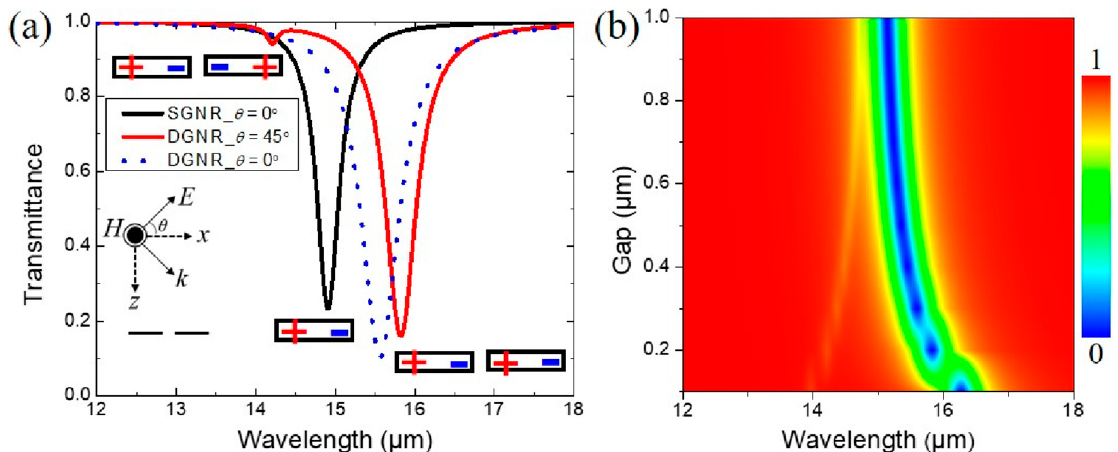
Figure 2. ( a ) Transmittance of the graphene nanoribbon dimer (GNRD) with d 1 = 0.2 μ m, with the inclined incidence angle ( θ ) being 0° and 45°, and the single GNR with θ being 0°. The insets of ( a ) show the corresponding plasmon mode for each spectral dip. ( b ) Transmittance of the GNRD under inclined incidence ( θ = 45°) of light with various d 1 .